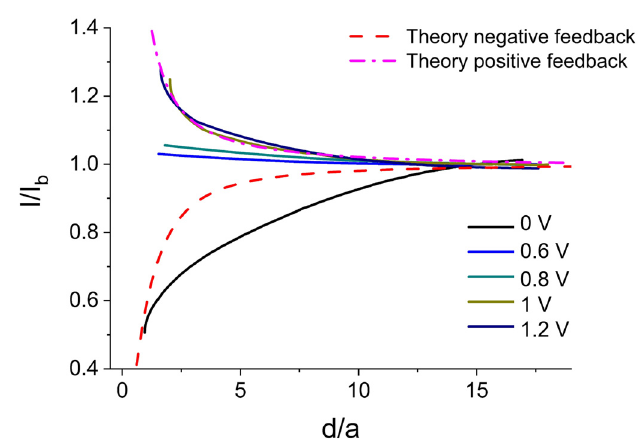
Figure 7. Approach curves recorded in a 2 mM K 3 Fe(CN) 6 + 0.1 M KCl water solution with the microelectrode tip biased at 0.0 V, above the oligo-( S )-BT 2 T 4 -Au biased at different potentials as indicated.